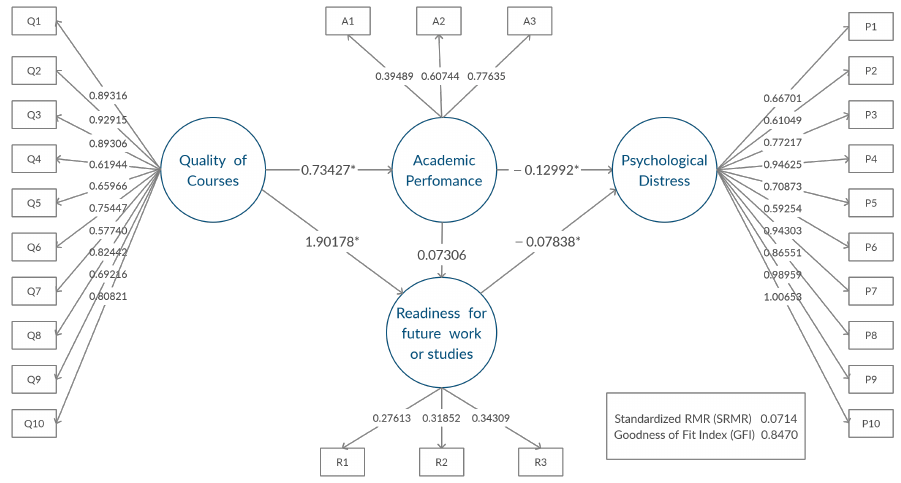
Figure 3. Path model for males, * significant relationship between latent